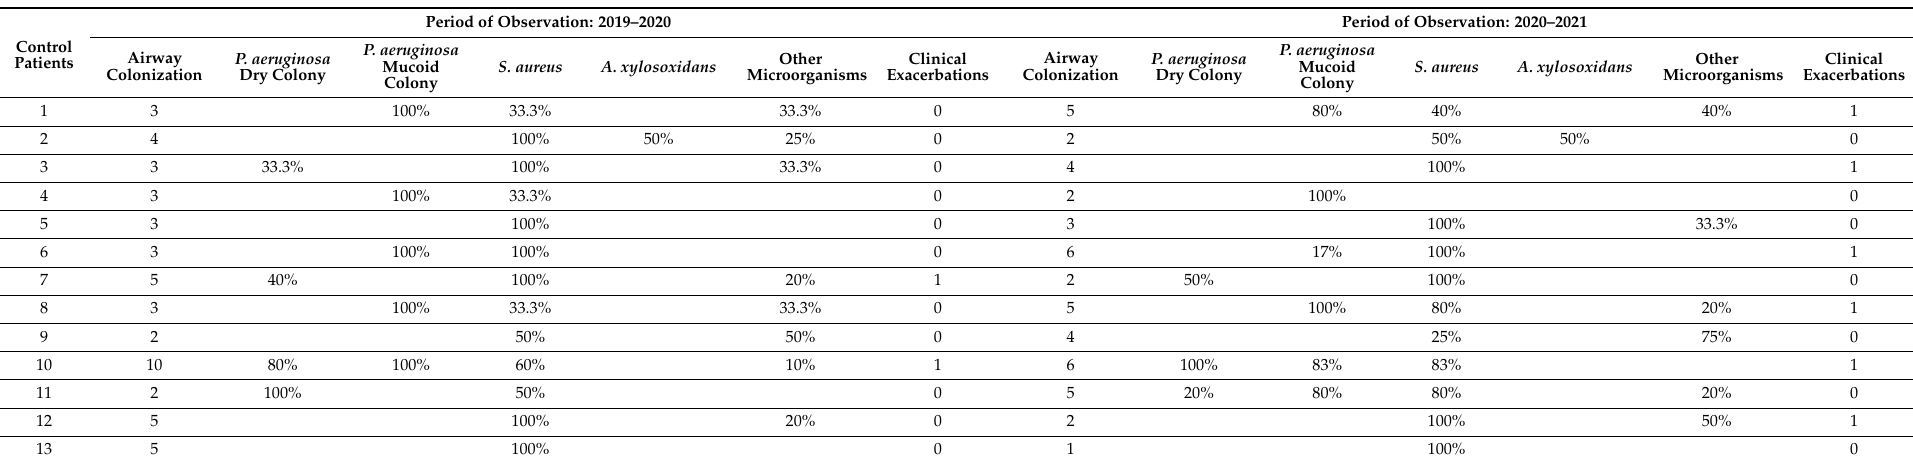
Table 4. Microbial prevalence in control group